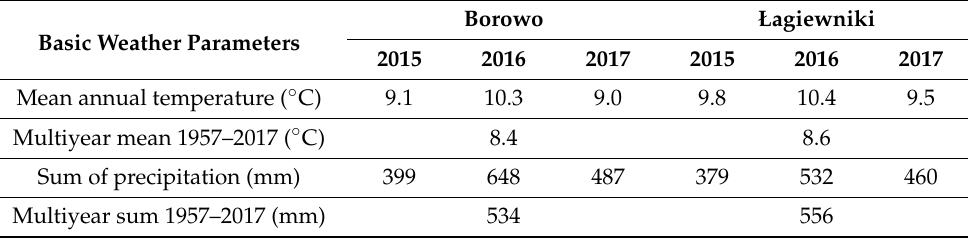
Table 4. Meteorological conditions in Borowo and Łagiewniki during the growing season of winter oilseed rape in 2015, 2016 and